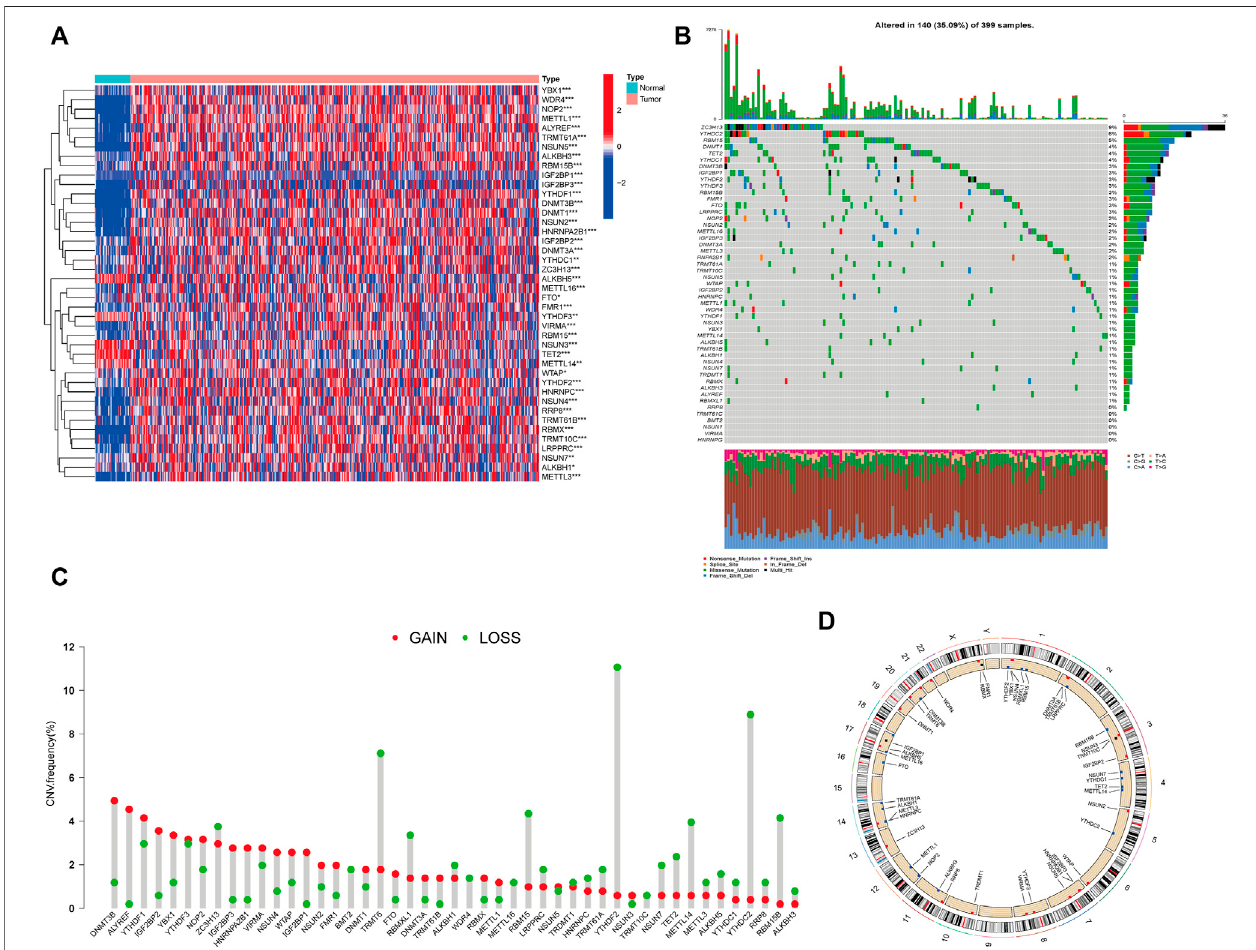
FIGURE 2 | Characteristics and differences of RNA methylation-related regulators in CC. (A) Heatmap of differential expression of RNA methylation-related regulators between normal ( n = 41) and colon cancer tissues ( n = 471) in the TCGA-CORD cohort. (B) Mutation waterfall plots of 399 colon cancer patients from the TCGA-CORD cohort. (C) Copy number variation (CNV) frequency ofRNA methylation-related regulators in the TCGA-CORD cohort. (D) The location ofCNV alterations of RNA methylation-associated regulators on chromosomes in the TCGA-CORD cohort. *p < 0.05; **p < 0.01; ***p <